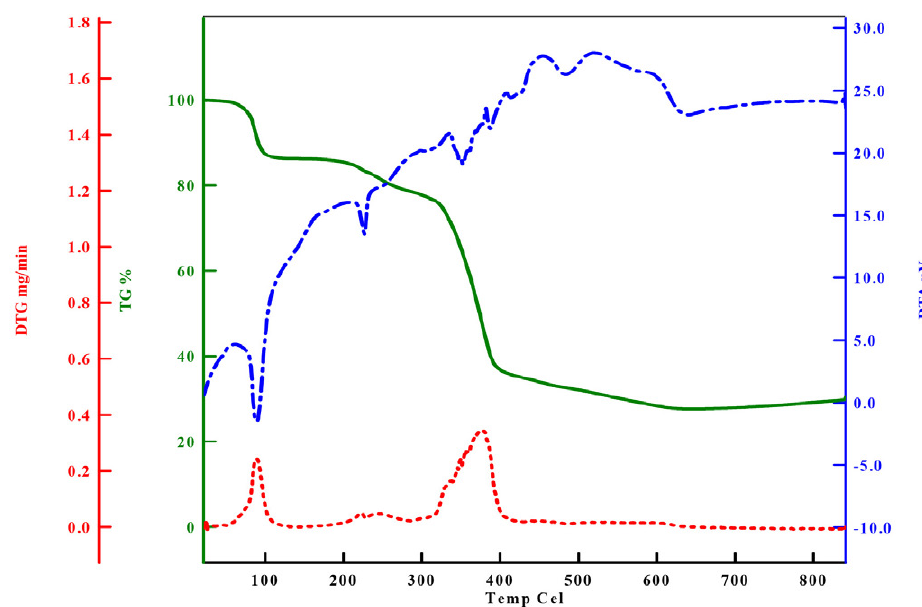
Figure 6. TGA curves of [Cd(IsoPht)(TEA)H 2 O]·3H 2 O